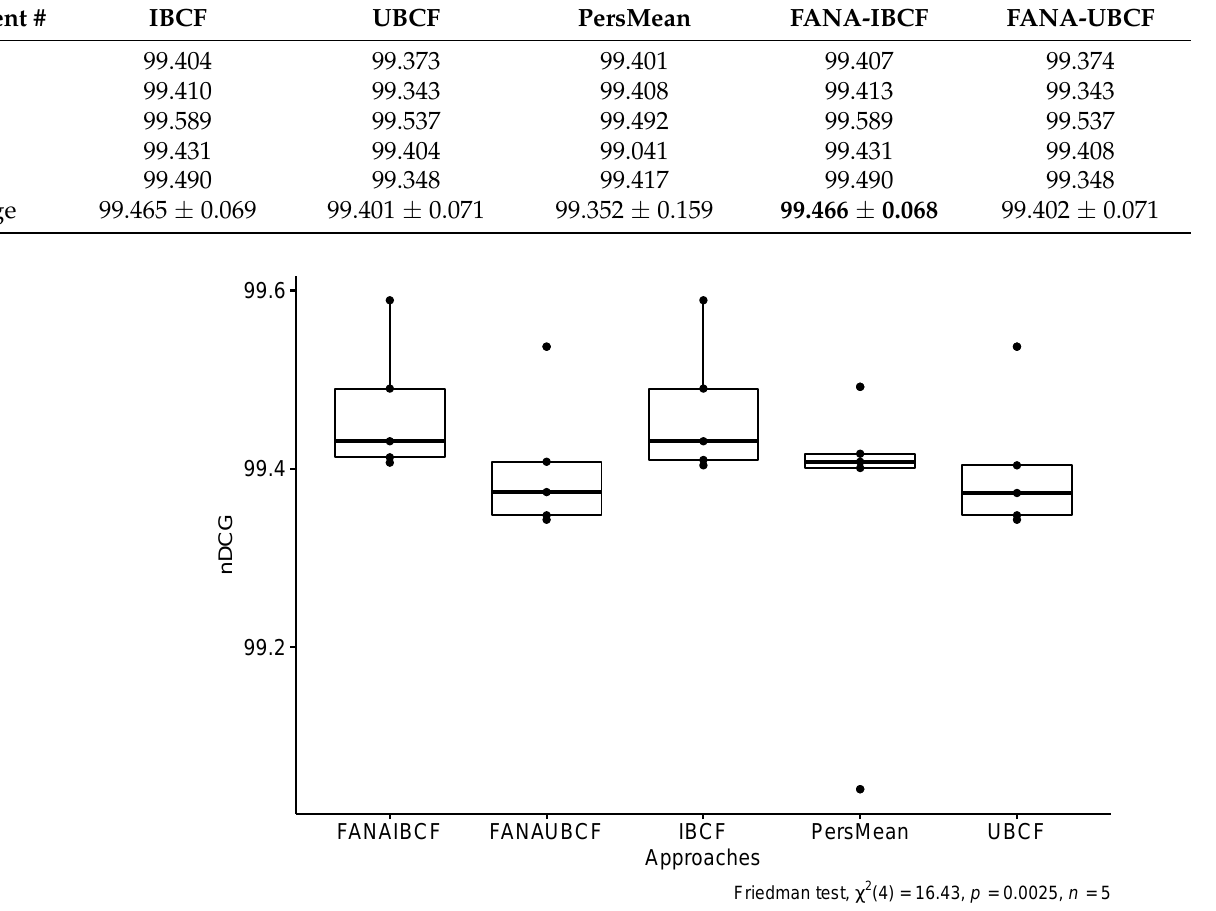
Figure 6. Box and whisker plot of nDCG with Friedman test results. Note that a p value < 0.05 means the experimental result is statistically significant.